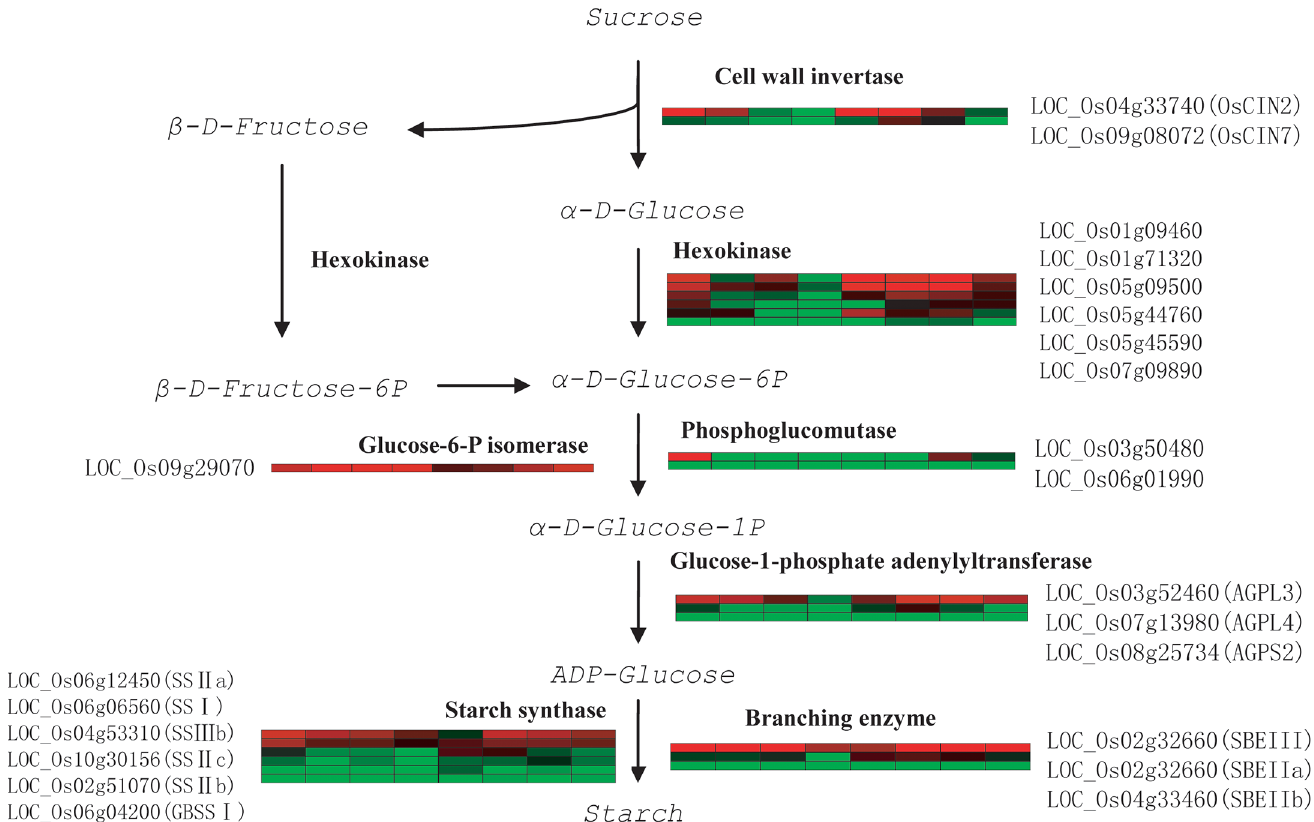
Fig 3. Schematic illustration of sucrose to starch synthesis pathway. Flow of substrates and products is indicated by arrows and enzymes catalyze the reaction are labeled beside arrows. Heat maps of the genes encoding the enzymes are placed beside the enzymes. Each grid indicates a sampled period. The first four grids indicate superior grains of 10DAF, 15DAF, 21DAF, 27DAF, and the last four grids indicate inferior grains of 10DAF, 15DAF, 21DAF, 27DAF. Expression of genes (in TPM) was subjected to log2 conversion. With those zero expression genes, zero was converted with 0.01(in